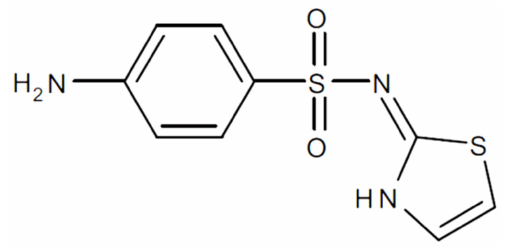
Figure 1. Chemical structure of